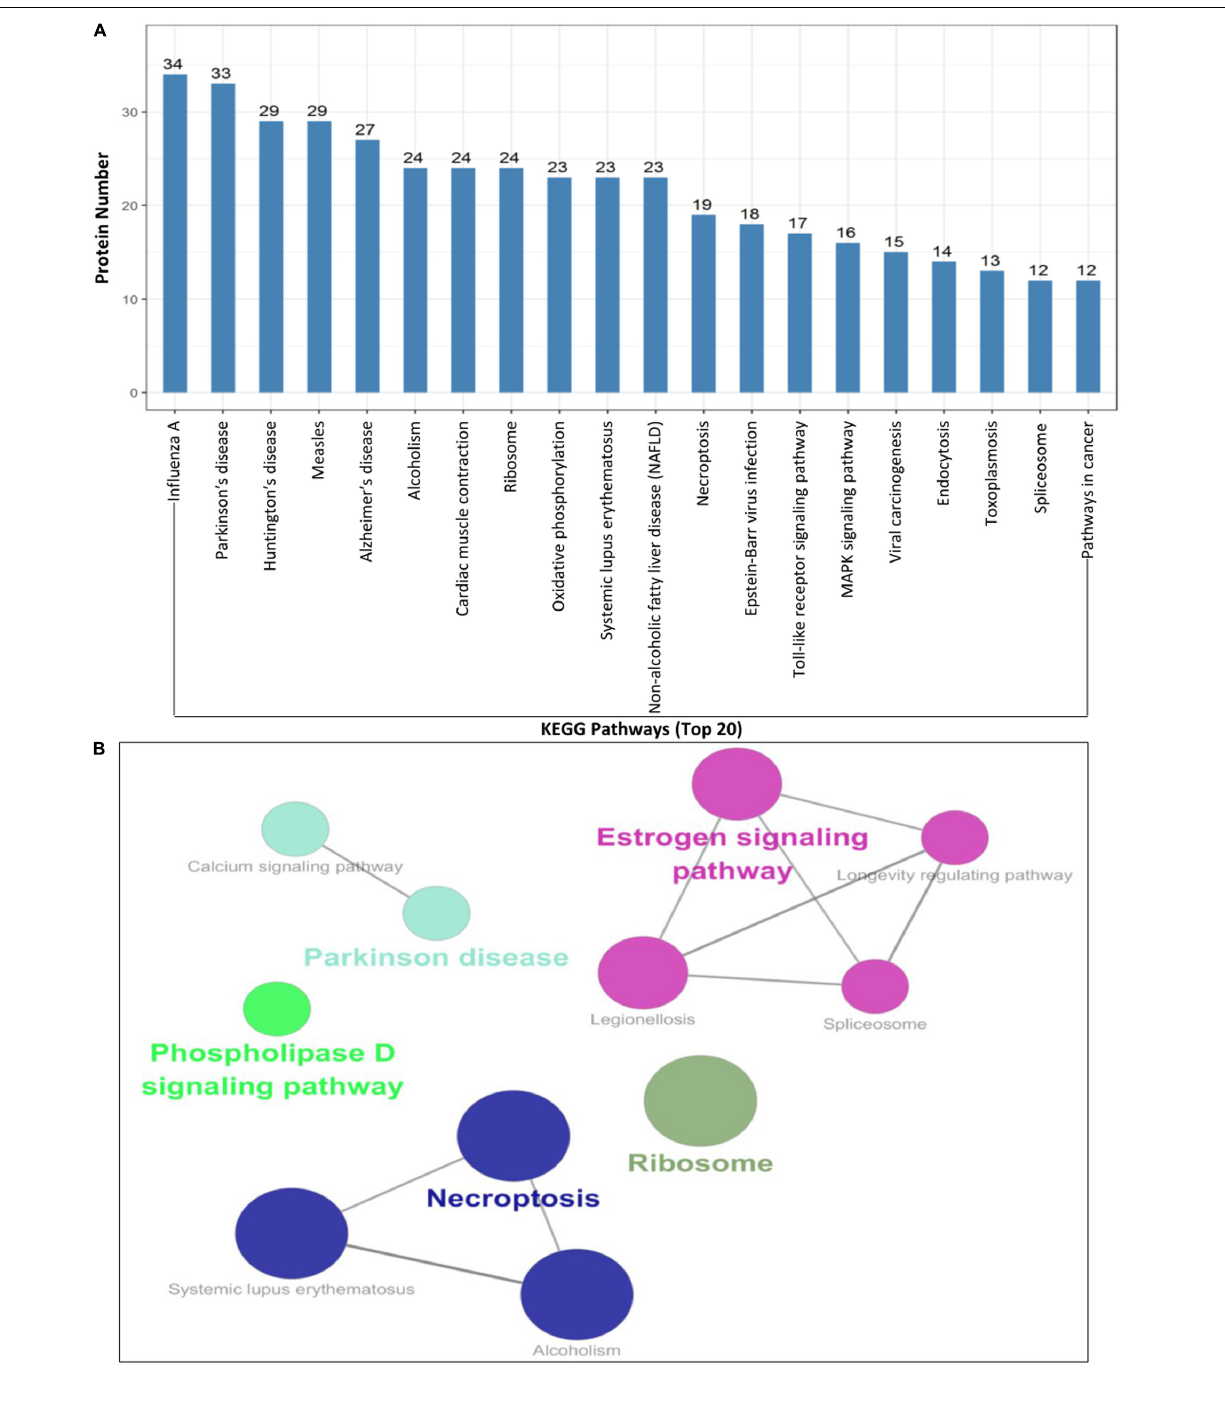
the GFP-Cap plasmid ( Figure 5B ). To investigate whether